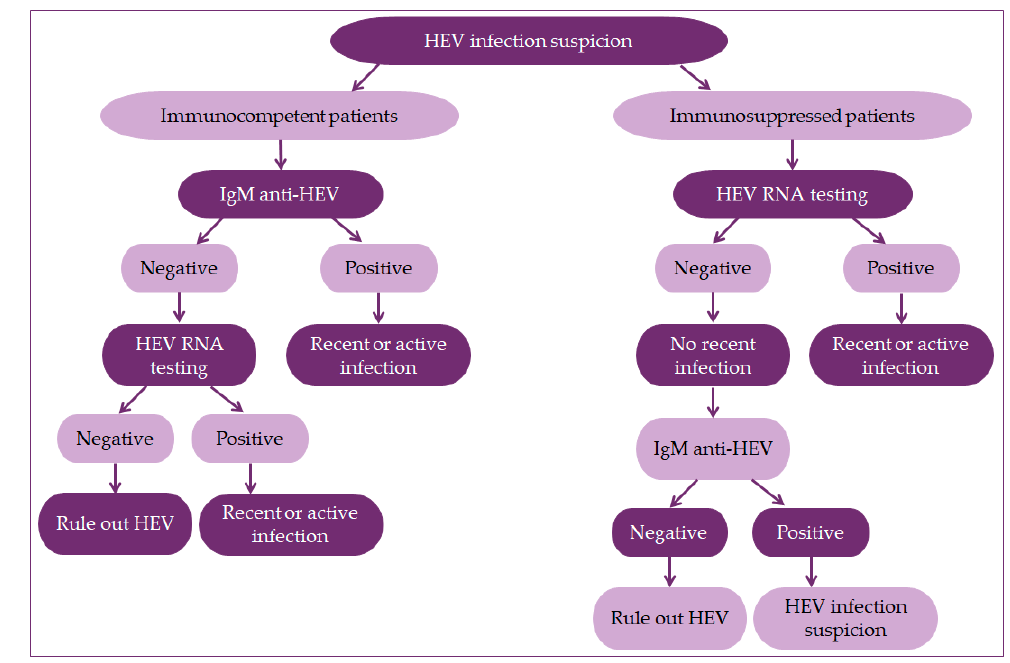
Figure 3. Algorithm for HEV infection diagnostic. Combining serological and nucleic acid testing is the best. The negative PCR test does not exclude the recent infection. Serology assays are sometimes negative in immunocompromised patients. Both negative test results rule out the HEV infection.